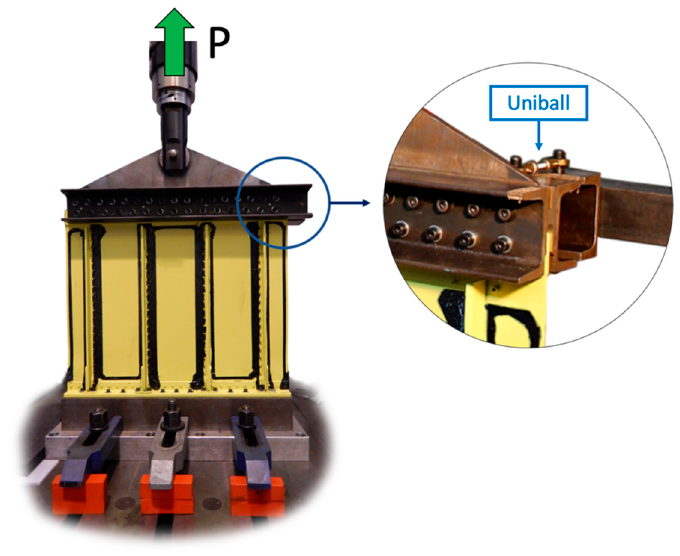
Figure 6. Experimental test rig.